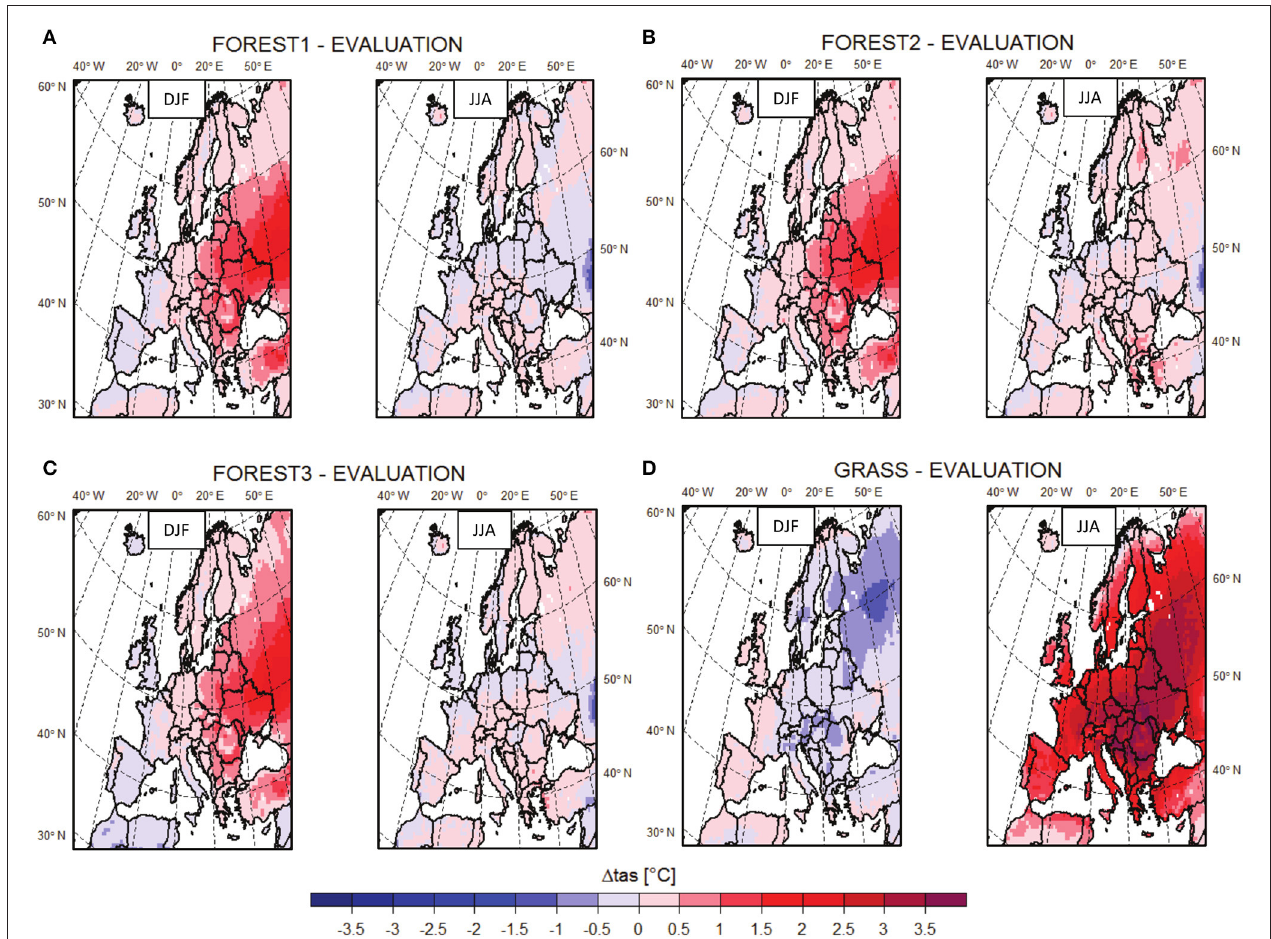
FIGURE 2 | Spatial distribution of mean seasonal near-surface air temperature changes over the EURO-CORDEX domain for the conversion to forest with three different albedo parameterizations [FOREST1 (A) , FOREST2 (B) , FOREST3 (C) ], and to grassland [GRASS (D) ] for winter (DJF, left) and summer (JJA, right) for 1986–2015. The difference between experiments and the EVALUATION simulation with no land cover change is displayed.